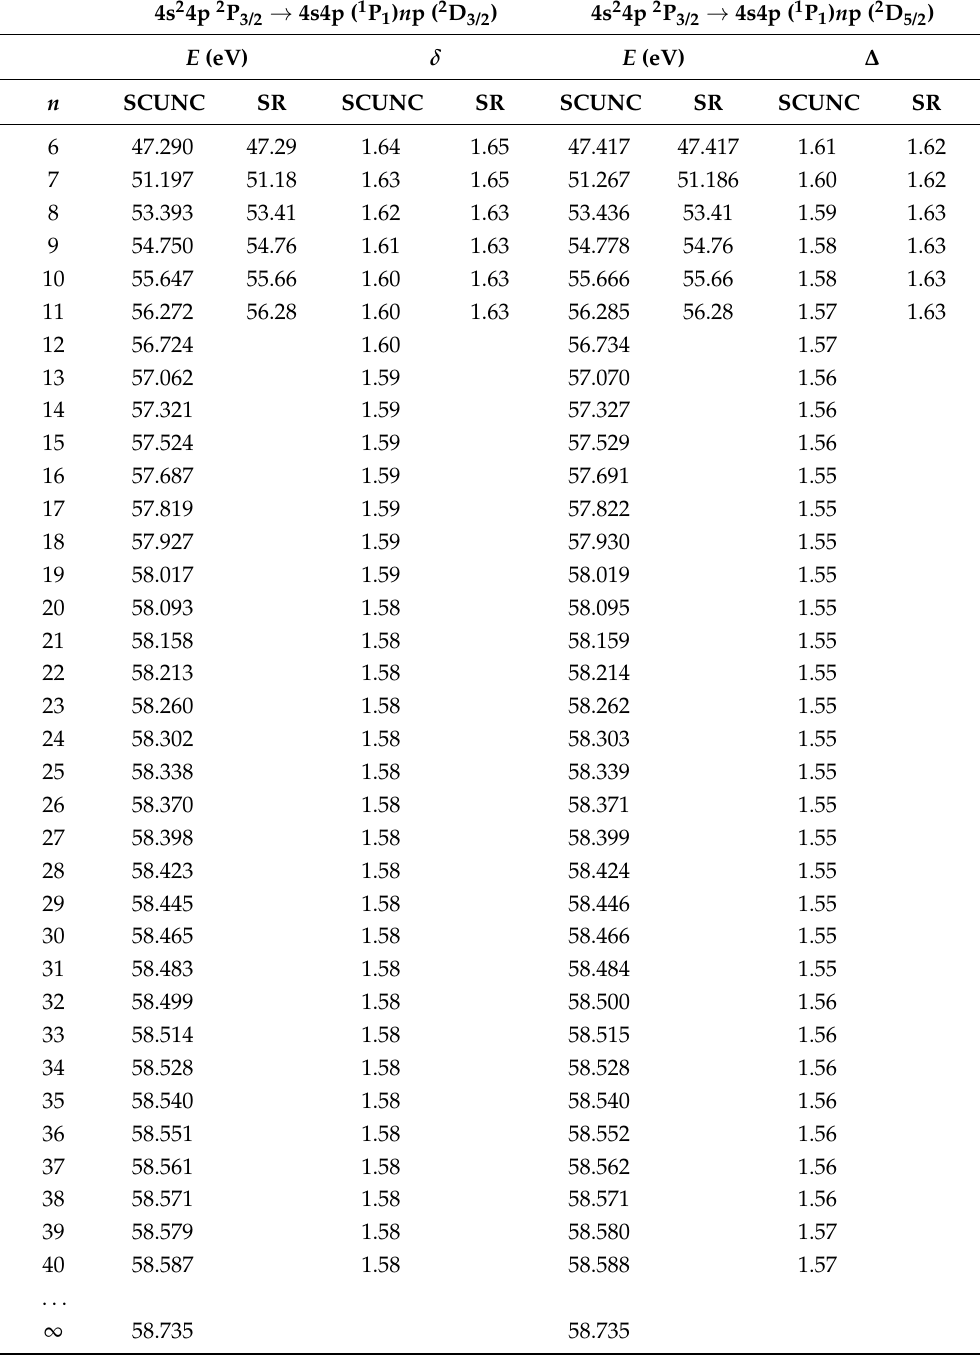
Table 5. Resonance energies (in eV) and quantum defects (dimensionless) of the 4s4p ( 1 P 1 ) n p ( 2 D 3/2 , 2 D 2 4p 2 P 3+ converging to the 1 P 1 series limit 5/2 ) Rydberg series originating from the 4s 3/2 states of Se in Se 4+ . The SCUNC results are compared to the SR measurements of Esteves et al. [22]. The screening constants are equal to: f 1 ( 1 P 1 , 2 D 3/2 ) = − 7.515 ± 0.028 and f 1 ( 1 P 1 , 2 D 5/2 ) = − 7.362 ±